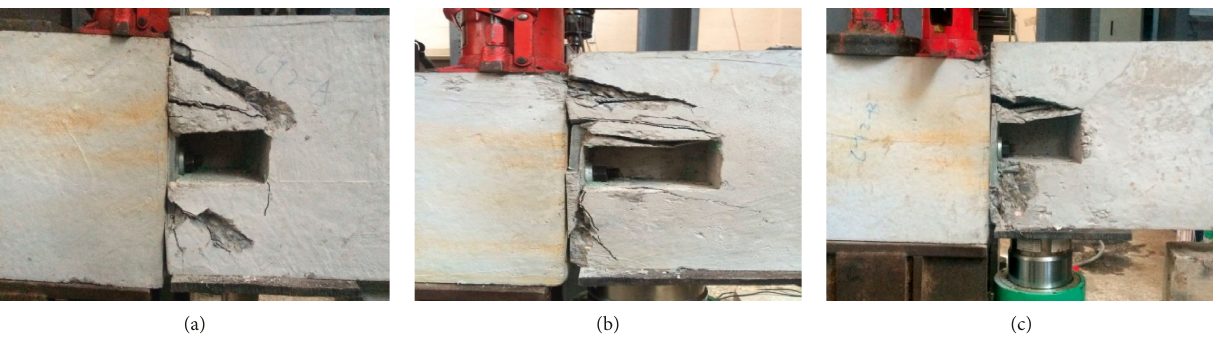
Figure 9: Failure mode of the specimens during the shear test: (a) S1, (b) S2, and (c)